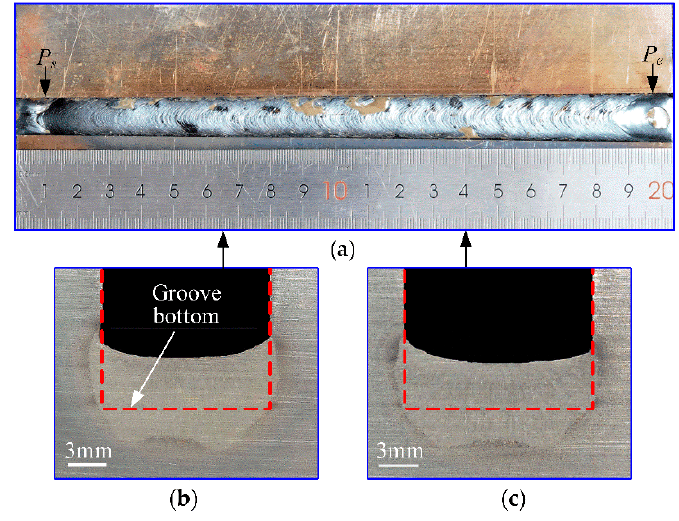
Figure 12. Photographs of weld formation in width-varying groove: ( a ) weld appearance; ( b ) bead cross-section at groove length of 65 mm; ( c ) bead cross-section at groove length of 140 mm.